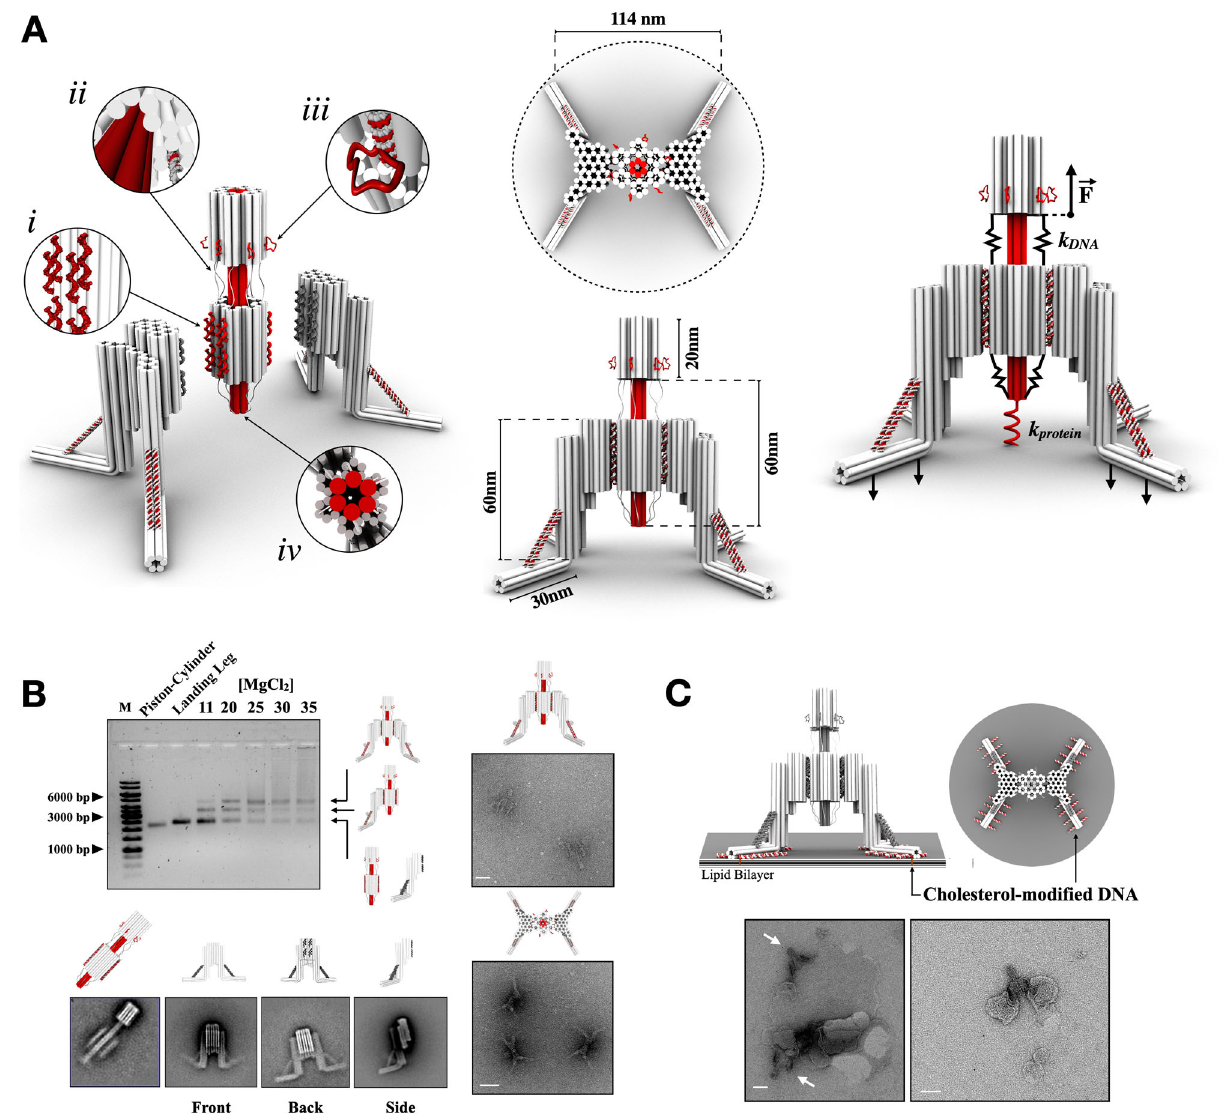
Fig. 1 Design and assembly of a DNA-based Nano-winch. A Schematic illustration of the assembly strategy of the DNA-based Nano-winch. Double-helical DNA domains are represented by cylinders and are packed on a honeycomb lattice. The Nano-winch comprises two origami in a 1:2 trimer, a central Piston-cylinder and two Landing Legs. The central piston-cylinder core origami has eight strands to anneal to the inner face of the Landing Leg origami (i). To prevent toppling, two ~30 nm six-helix bundles project at 90° from the origami landing legs and 45° away from each other to lay parallel to a surface and maximize area coverage to retain an upright position. They are reinforced with a dsDNA strut. Single-stranded DNA connectors link the top and bottom of the cylinder to the backstop and the piston tip, respectively (ii). These single-stranded DNA connectors loops act as entropic springs with stiffness k DNA and exert de fi ned force which is mechanically translated through the rigid origami to the tip of the piston coupled to a molecular target with stiffness k protein. The length of these connectors can be adjusted by storing the excess scaffold in reservoir loops on the backstop (iii). The tip of the piston positions up to three ligand moieties targeting speci fi c cell surface receptors (iv). Extension of the Piston results in equivalent and opposing compressive force through the Landing Legs. B 1.0% agarose gel with 11 mM MgCl 2 on which the following samples were electrophoresed: M, 1-kb ladder, Piston-cylinder monomer, Landing Leg monomer, and Piston-cylinder incubated with two-fold molar excess of Landing Legs with a concentration gradient from 11 mM to 35 mM MgCl 2 . Schematic representations and reference-free class averages from single-particle TEM micrographs of individual components (particle sets available in Supplementary Figs. 5, 8, and 9). Fully assembled Nano-winch particles were visualized both laterally and from above. C Each landing leg can be modi fi ed with eight cholesterol moieties, for a total of 32-modi fi cations. Example TEM images of Nano-winches functionalized with cholesterol moieties adhering to small unilamellar vesicles through the landing legs. Distortions of liposomes is an effect of the process of sample preparation for negative stain TEM. White bars represent 50 nm. All TEM analyses were conducted at least three times for each sample. Source data are provided as a Source Data fi of the corresponding reservoir loops to change this extension. analysis (Supplementary Figs. 19 – 22). To estimate the amount of Two additional designs with 60 nt and 30 nt connectors were force applied by the 97 nt connector device in autonomous mode, assembled and evaluated by TEM (Fig. 2C, D). The mean we fi rst approximated the countervailing top and bottom ssDNA distribution distances of 14.0 nm and 9.3 nm were evaluated for connectors as entropic springs using a Worm Like Chain model the 60 nt and 30 nt device, respectively, from TEM single-particle (WLC) with the device attached to a simpli fi ed target molecular